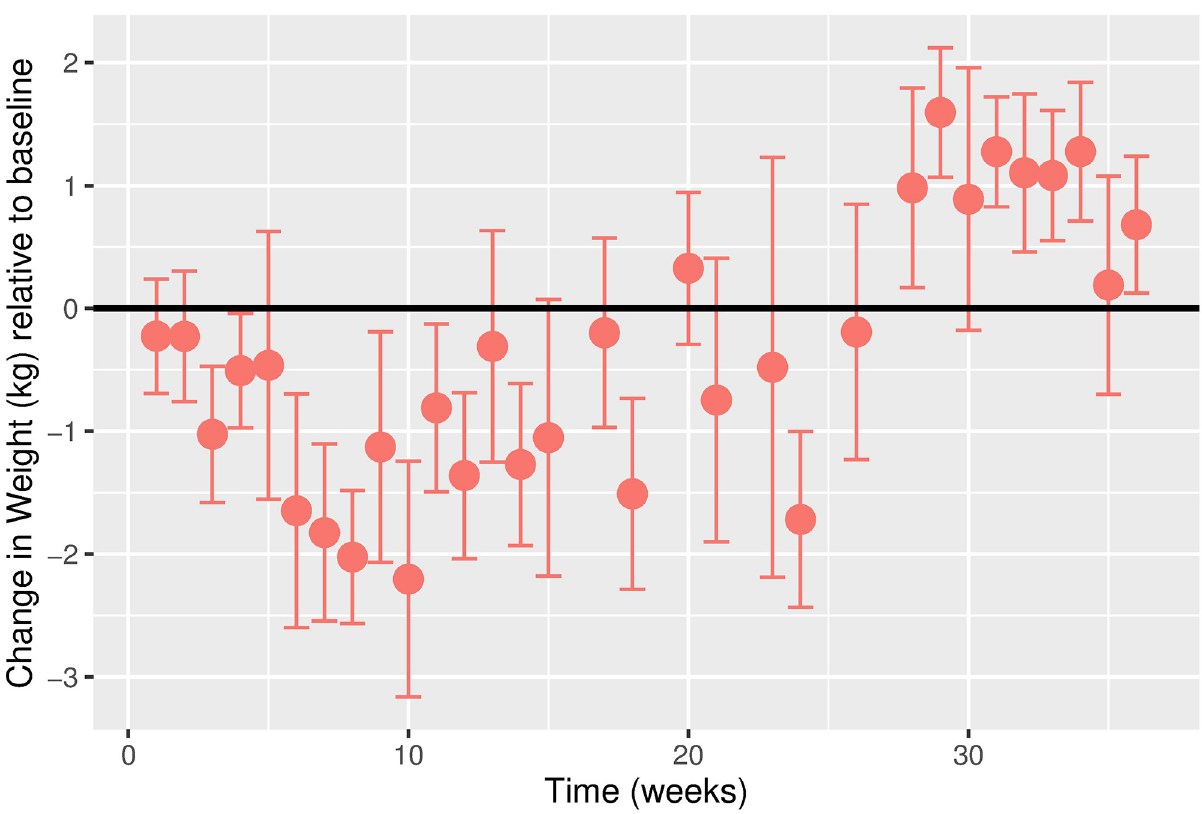
Fig 4. Estimated change in weight (kg) relative to baseline over time in weeks for females. Error bars represent the 95% confidence intervals. Change in Weight (kg) relative to baseline. Time (weeks). Error bars represent the 95% confidence intervals.